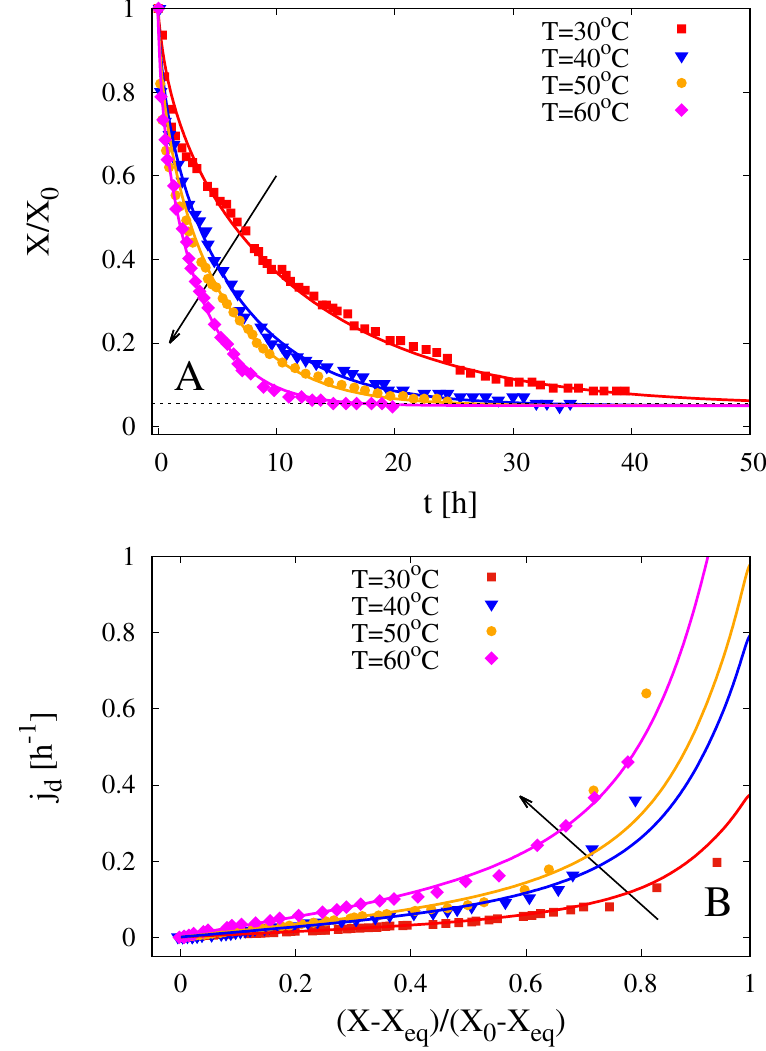
Figure 9. ( A ) Dehydration curves X / X 0 vs. t (h) and ( B ) dehydration-rate curves j d (h − 1 ) vs. X r for T = 30 ◦ C, 40 ◦ C, 50 ◦ C, 60 ◦ C and v = 0.6 m/s. Cocoa bean from data set (1). Comparison between experimental data (points) and model predictions (continuous lines) with water diffusivities D and Biot numbers Bi m reported in Table 5. Arrows indicate increasing values of T . Dashed line indicates the asymptotic rescaled moisture content X eq / X 0 =